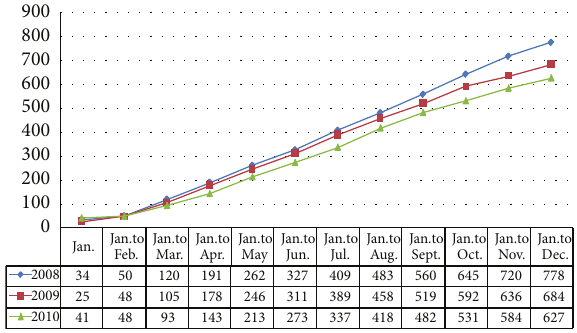
Figure 1: Number of safety accidents in the construction industry (2008–2010).